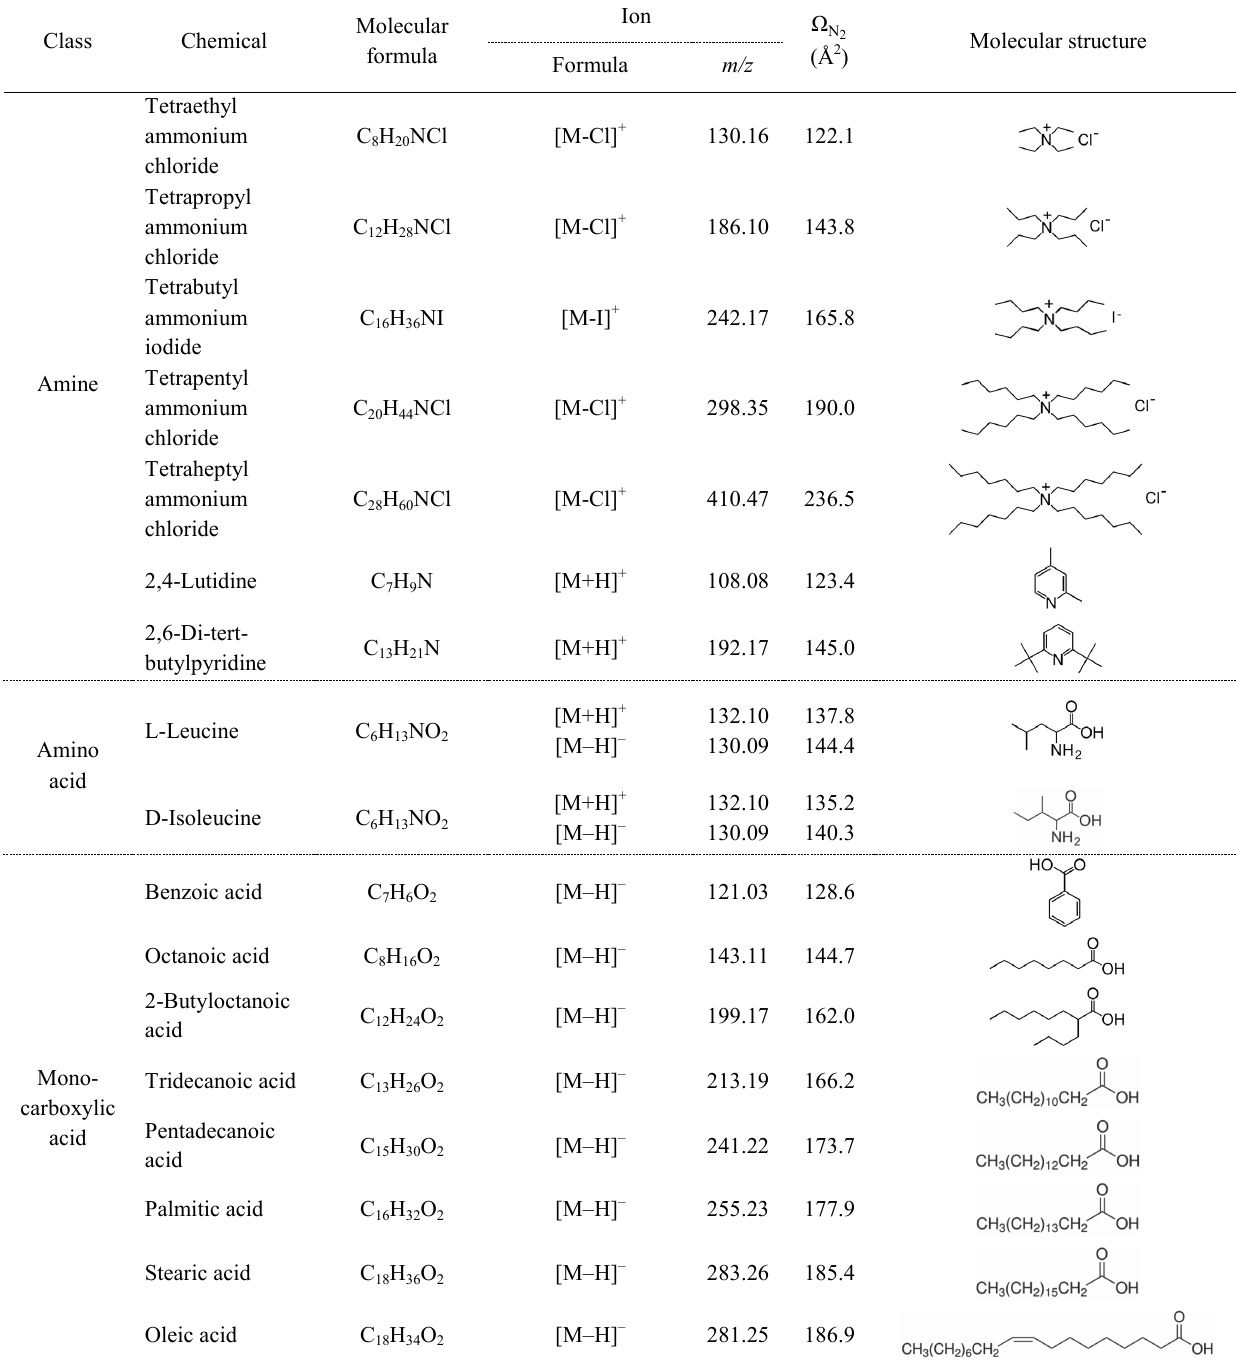
Table 1. Overview of organic standards investigated in this